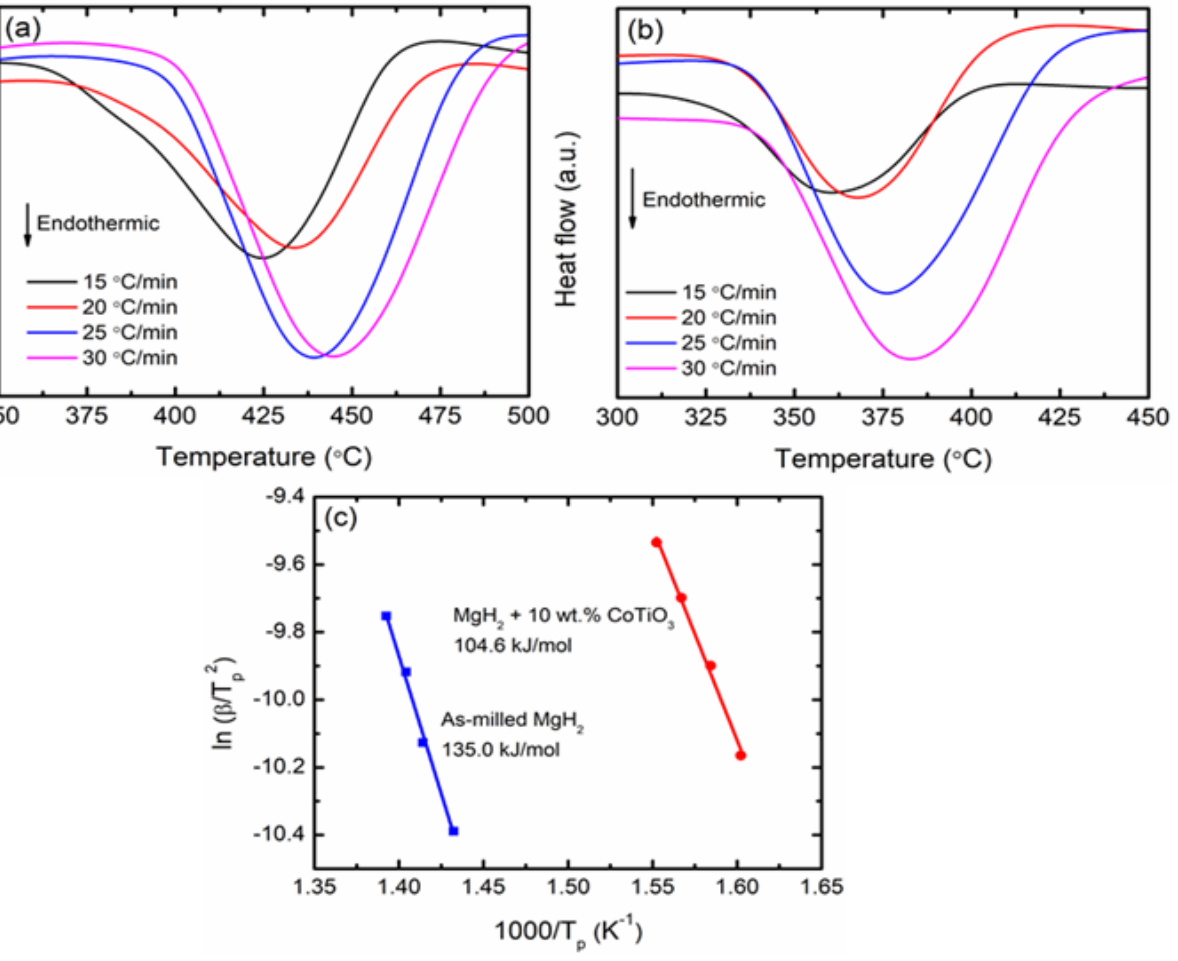
Figure 6. DSC curve of ( a ) as-milled MgH 2 , ( b ) MgH 2 + 10 wt.% CoTiO 3 (Heating rate: 15, 20, 25, and 30 °C/min) and ( c ) Kissinger plot of undoped MgH 2 and MgH 2 + 10 wt.% CoTiO 3 .